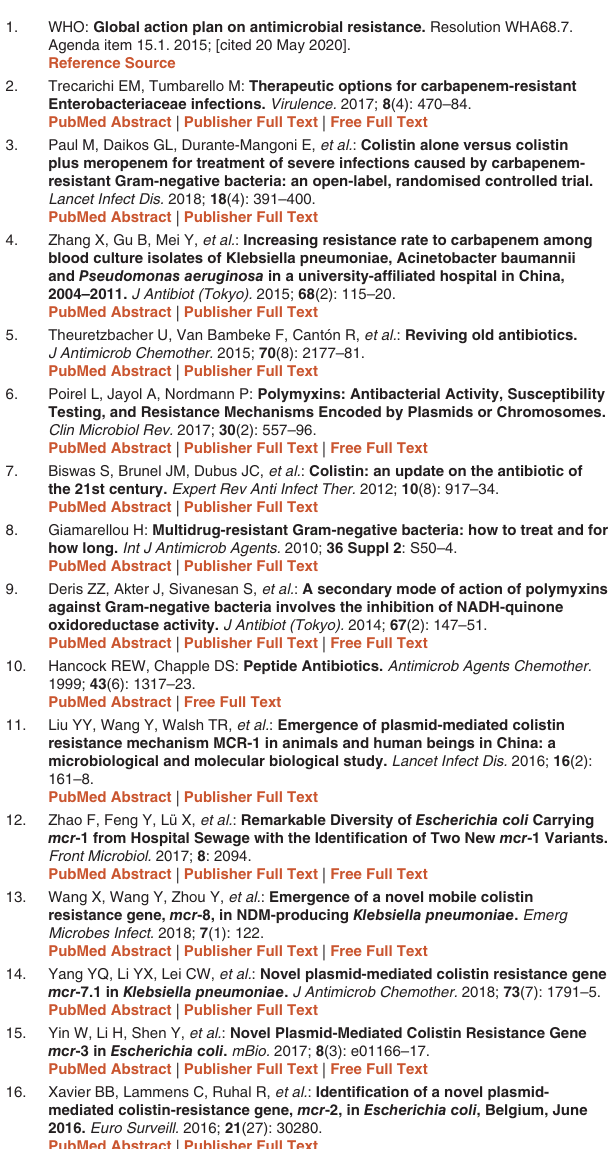
Figshare: Full list of included studies .bib.